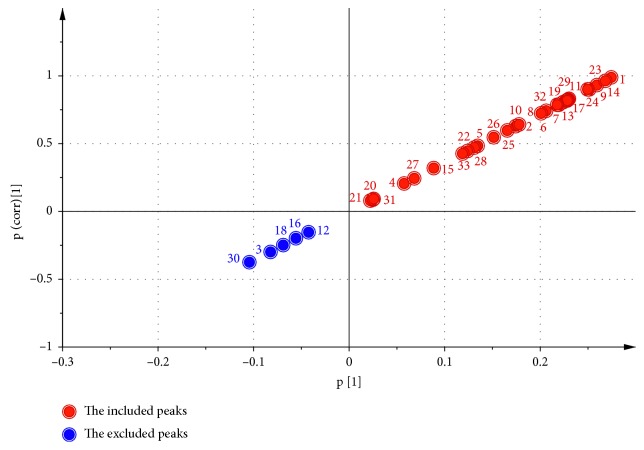
The S-plot of peaks.